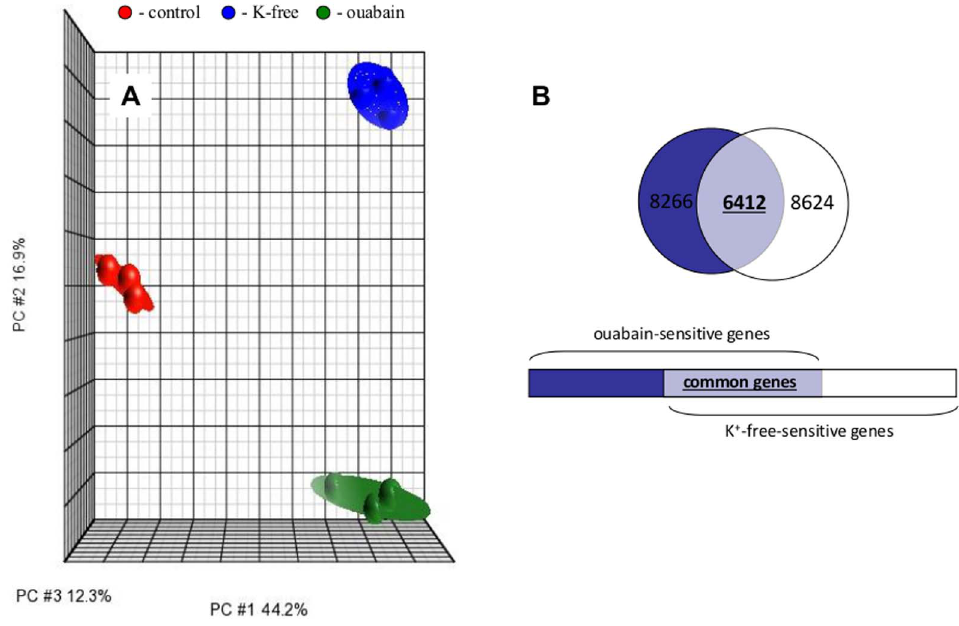
Figure 3. Effect of Na + ,K + -ATPase inhibition on the RASMC transcriptome. Cells were incubated for 6 hr in control DMEM, K + -free DMEM or DMEM containing 3 mM ouabain. All experiments are repeated 3 times. A . PCA of transcriptomic changes. Ellipsoids highlight portioning of samples based on type of treatment. The principal components in 3-dimensional graphs (PC # 1, PC # 2 and PC # 3) represent the variability of gene expression level within datasets. B . Comparative analysis of the impact of Na + ,K + -ATPase inhibition by ouabain and K + -free medium on the RASMC transcriptome. The total number of genes whose expression is altered by ouabain and K + -free medium by more than 1.2-fold with p , 0.05 is indicated; the number of genes affected by both stimuli appears in bold .